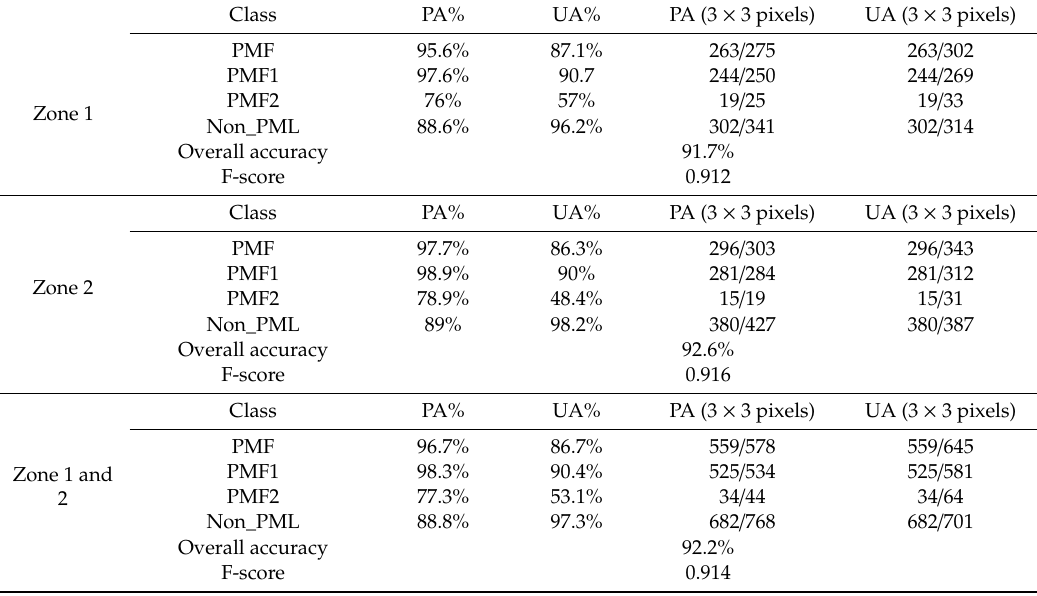
Table 6. Confusion matrix for the PFMA using a mosaic image in 2016 for each